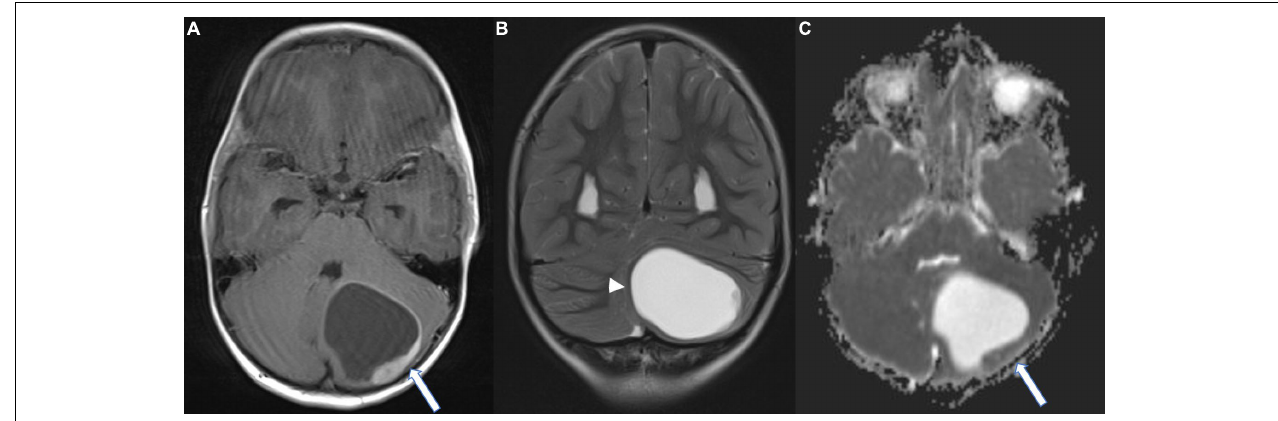
FIGURE 1 | Magnet resonance (MR) images at the time of diagnosis; (A) Axial T1-weighted contrast-enhanced image showing a left cerebellar cystic mass with a peripheral contrast enhancing component (arrow); (B) Coronal T2-weighted image. Note the infratentorial midline shift due to the mass effect of the cystic component (arrowhead). (C) Axial diffusion-weighted image (ADC-Map) demonstrating low ADC values of the solid component (arrow), suggestive of high cellular density.